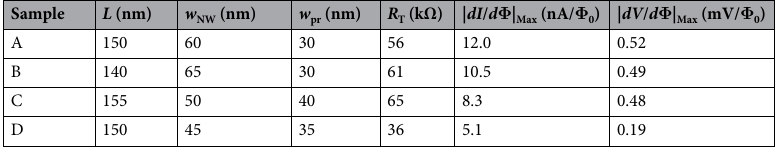
Table 1. Parameters of different SQUIPT samples. L is the interelectrode spacing, w NW denotes the width of the superconducting nanowire, while w pr is the width of the Al probe. The tunnel resistance R T , the maximum absolute values of the flux-to-current (| dI / d Φ | Max ) and flux-to-voltage (| dV / d Φ | Max ) transfer functions are measured at T bath = 25 mK.